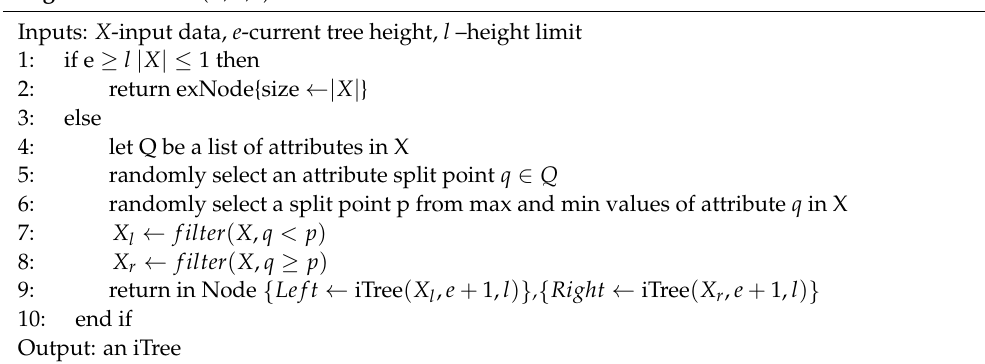
Algorithm 2 iTree (X, e, l